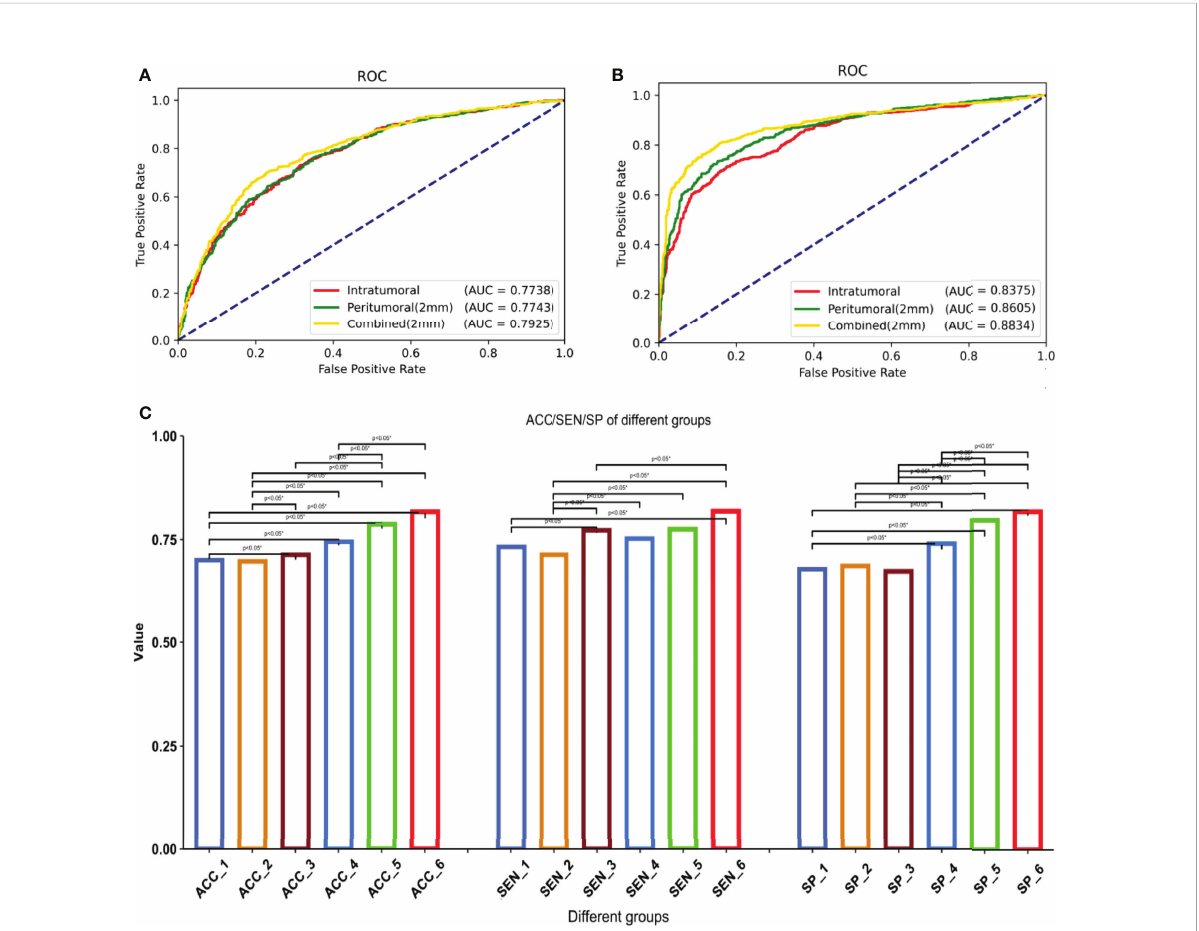
FIGURE 5 1 – 6 are respectively: radiomics-tumoral; radiomics-peritumoral 2 mm; radiomics-combined 2 mm; deep learning-tumoral; deep learning-peritumoral 2 mm; deep learning-combined 2 mm models. (A) ROC curve and AUC of the radiomics models, including 1 – 3. (B) ROC curve and AUC of the deep learning models, including 4-6. (C) Differences among all models in accuracy, sensitivity, and speci fi city. *Statistical signi fi cance.